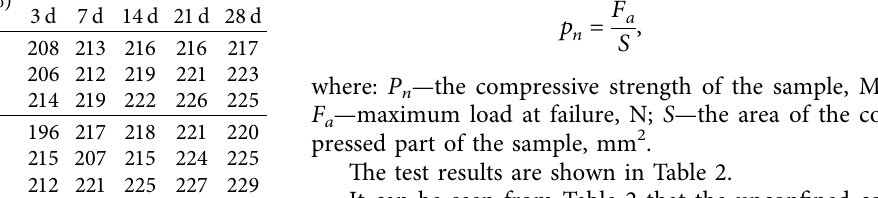
Table 1: Surface hardness of the